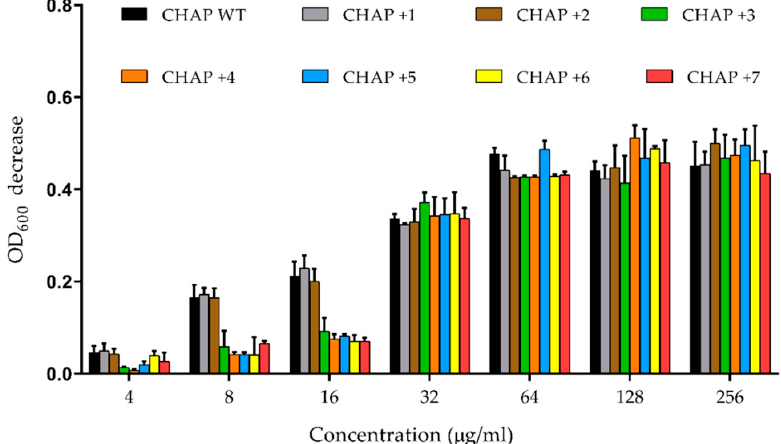
Figure 4. In vitro lytic activity against S. pyogenes D471. The different concentrations of enzymes were added to the overnight bacterial cultures. The OD 600 was recorded every 15 seconds for 1 hour. The OD 600 decrease, which is the net change in OD 600 between the PBS treated control and enzyme treatment for 1 hour, was represented as the enzyme activity. The experiment was conducted in triplicate, and the error bars represent the standard deviation.